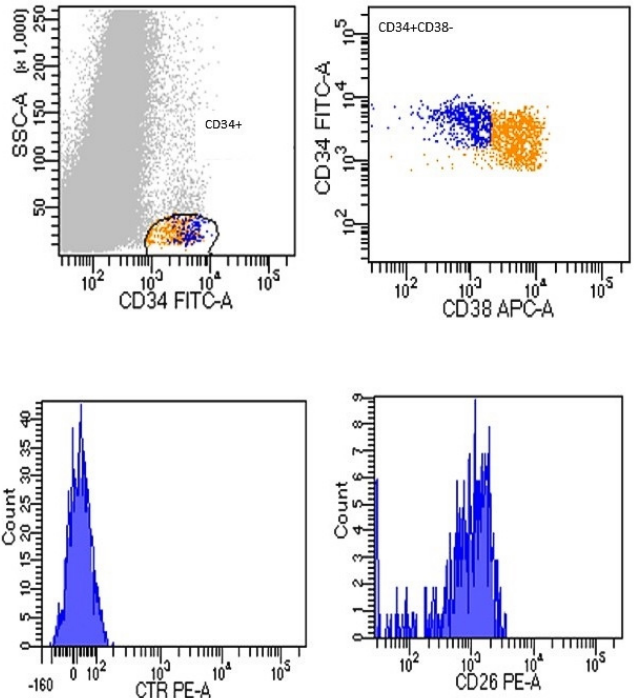
Figure 2. Flow cytometry CD26 expression on PB sample of CML at diagnosis. After a selection of cellular compartment CD34+/CD38 − ( upper boxes), the fraction CD26+ was selected within them (boxes on down , represented as histograms). Acquisition of at least 1 × 10 6 cells was performed by using FACSCanto II flow cytometry instrument (BD, Biosciences, San Jose, CA, USA).